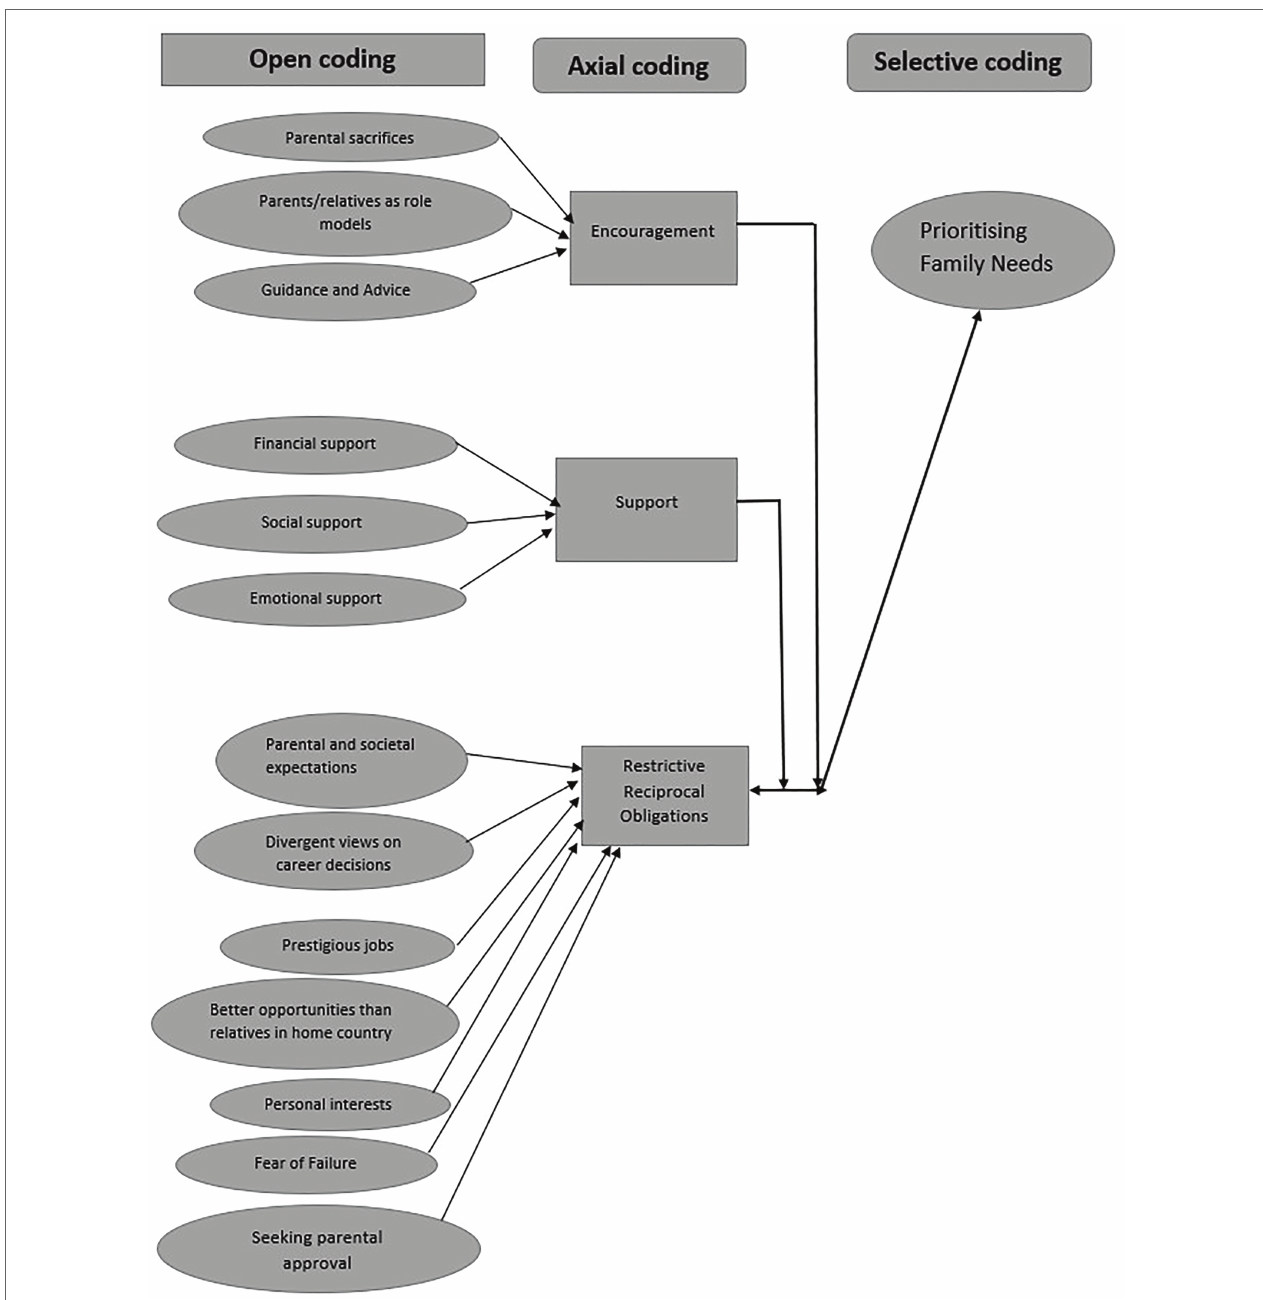
FIGURE 1 | The three phases of